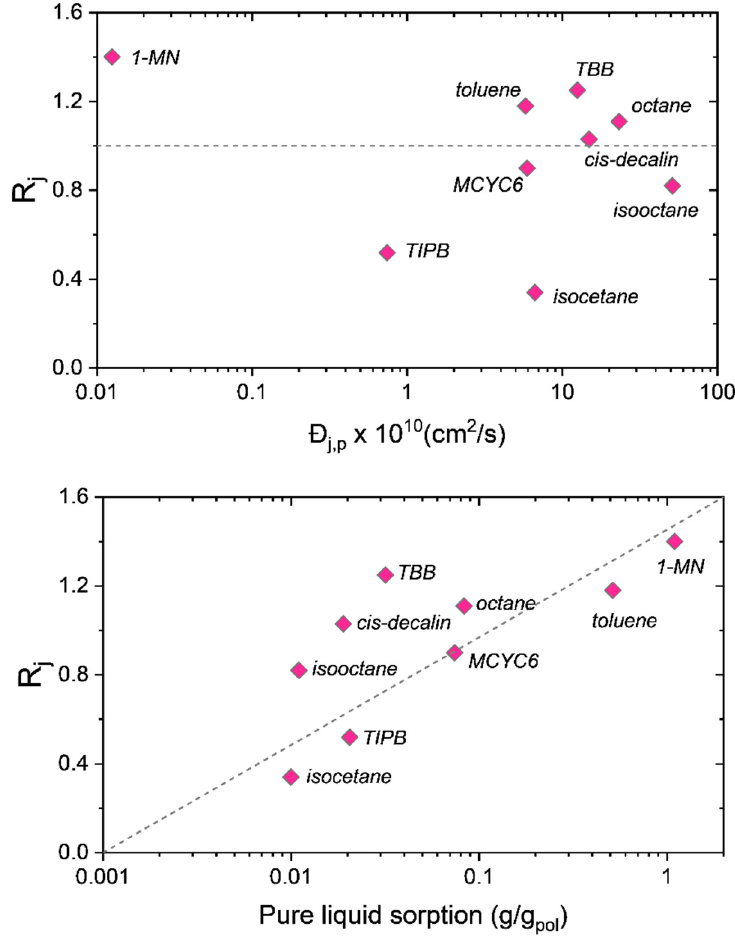
Figure 3. Separation coefficients of the nine-component mixture in the SBAD-1 membrane [3] versus Maxwell–Stefan diffusivities [9] ( top ) and sorption data from pure component liquids [8] ( bottom ). The membrane separation was done at a temperature of 22 °C and trans-membrane pressure 40 bar. Dashed lines are included as visual guides. MCYC6 = methylcyclohexane, TBB = tert-butylbenzene, TIPB = 1,3,5-triisopropylbenzene, 1-MN = 1-methylnaphthalene.